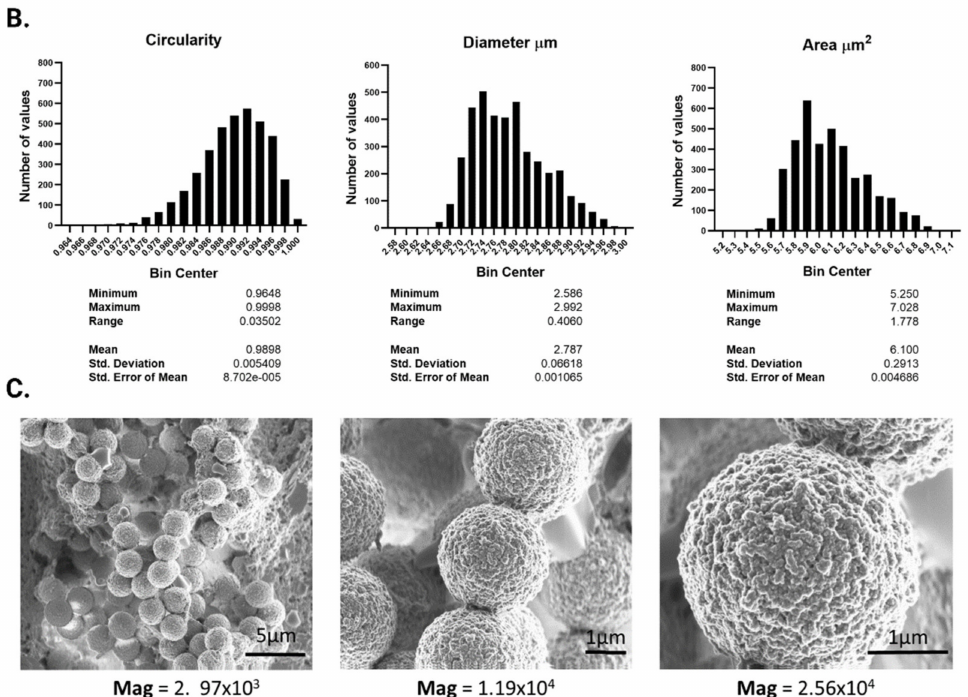
Figure 2. ( A ) Representative images obtained by image cytometry. ( B ) Histograms showing the frequency distribution of circularity, with perfect circularity = 1, diameter expressed in µ m, and area expressed in µ m 2 . ( C ) Representative SEM micrographs of the Dynabeads TM , obtained at several magnifications